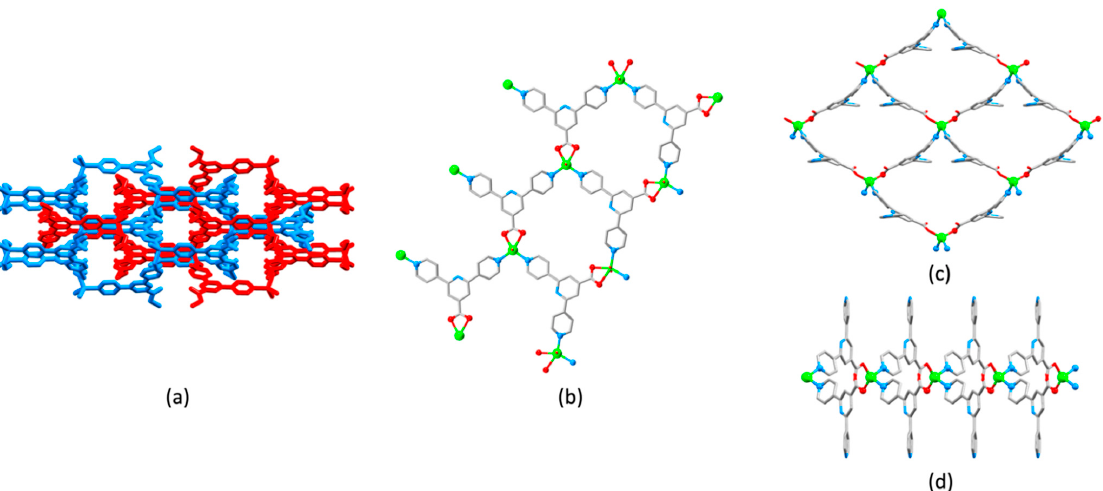
Figure 20. ( a ) Part of the 2-fold interpenetrating 3D-nets in [Zn 2 ( 31 ) 2 (O 2 CH) 2 ] n · 3.5 n H 2 O (CSD refcode KEPKEY). ( b ) Part of the 2D, 6 3 net in [{Zn 2 ( 31 ) 2 (OH 2 ) 4 } n ] · [MeCO 2 ] 2 n · n H 2 O (refcode KEPKOY). Parts of the (4,4) net in [Zn( 31 ) 2 ] n · n H 2 O (refcode KEPLAV) viewed ( c ) down the crystallographic c -axis, and ( d ) down the a -axis, i.e., into the plane of the 2D-sheet.